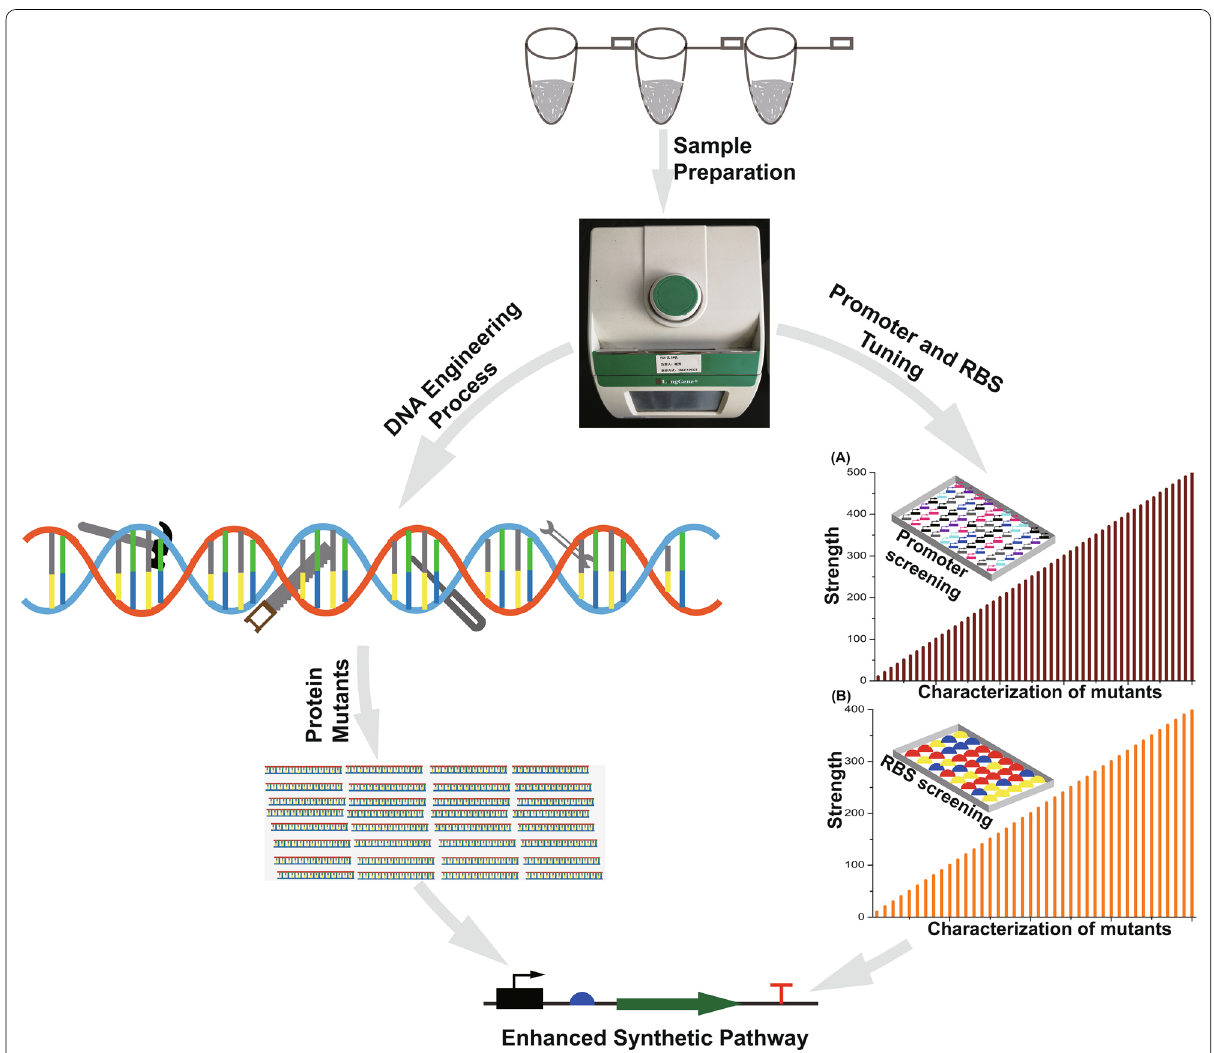
Fig. 4 Schematic diagram for producing enzyme, promoter, and RBS library construction and screening. Directed evolution, site‑directed mutagenesis, DNA shuffling can be employed to enhance enzyme and regulatory elements efficiency. Engineered promoters and RBS can be used to fine‑tune biosynthetic